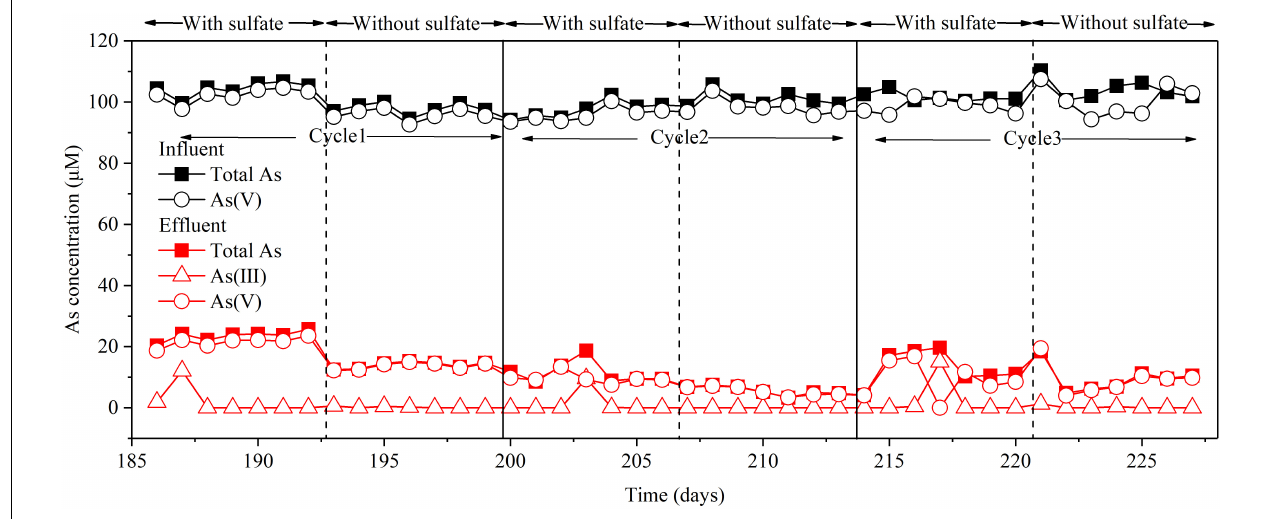
FIGURE 6 | Effect of sulfate on As(V) removal in the BES cathode chamber. Experimental conditions: influent [As(V)] = 100 µ M, (Na 2 SO 4 ) = 3.3 mM, I cell = 30 mA. Cycle 1, Cycle 2, and Cycle 3 represent three replicates of with or without sulfate.